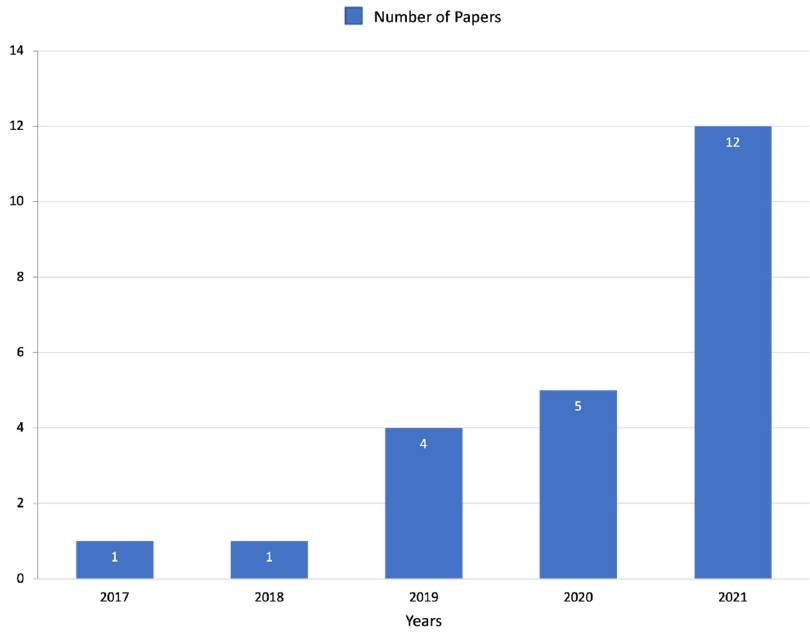
Figure 1. Study selection process flowchart according to the PRISMA Statement 2020 [12].